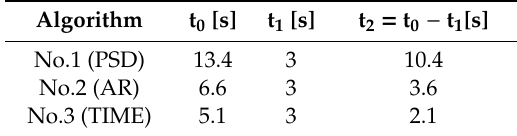
Table 1. Results of the delay estimation for selected